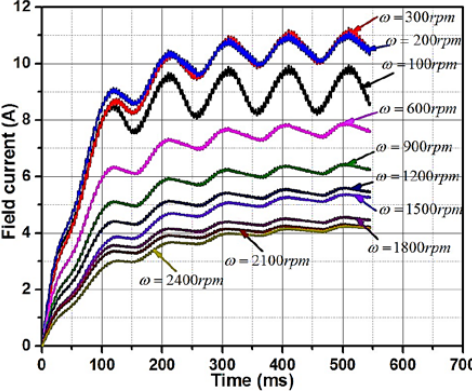
Figure 13. Rotor field winding currents for different speeds. Table 4. Wide-Speed Performance of BL-WRVM.